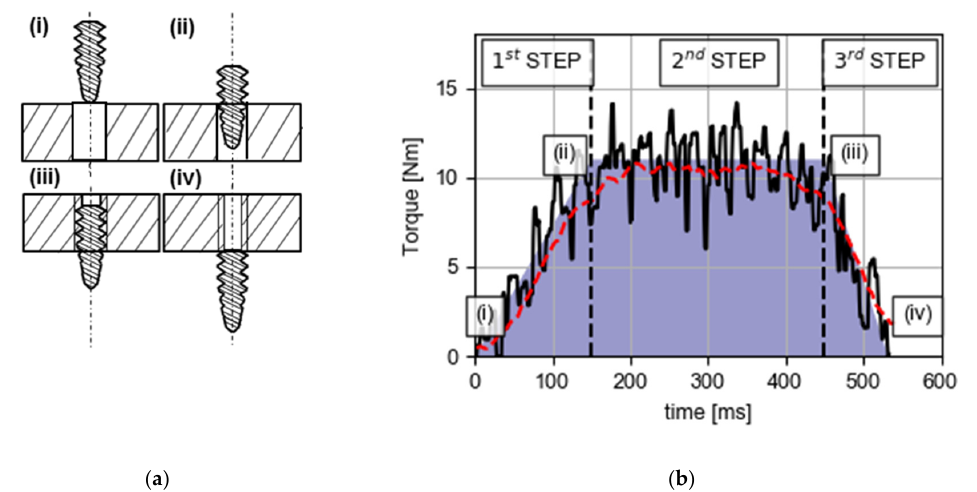
Figure 8. Threading step ( a ) and torque signals ( b ) during threading process.